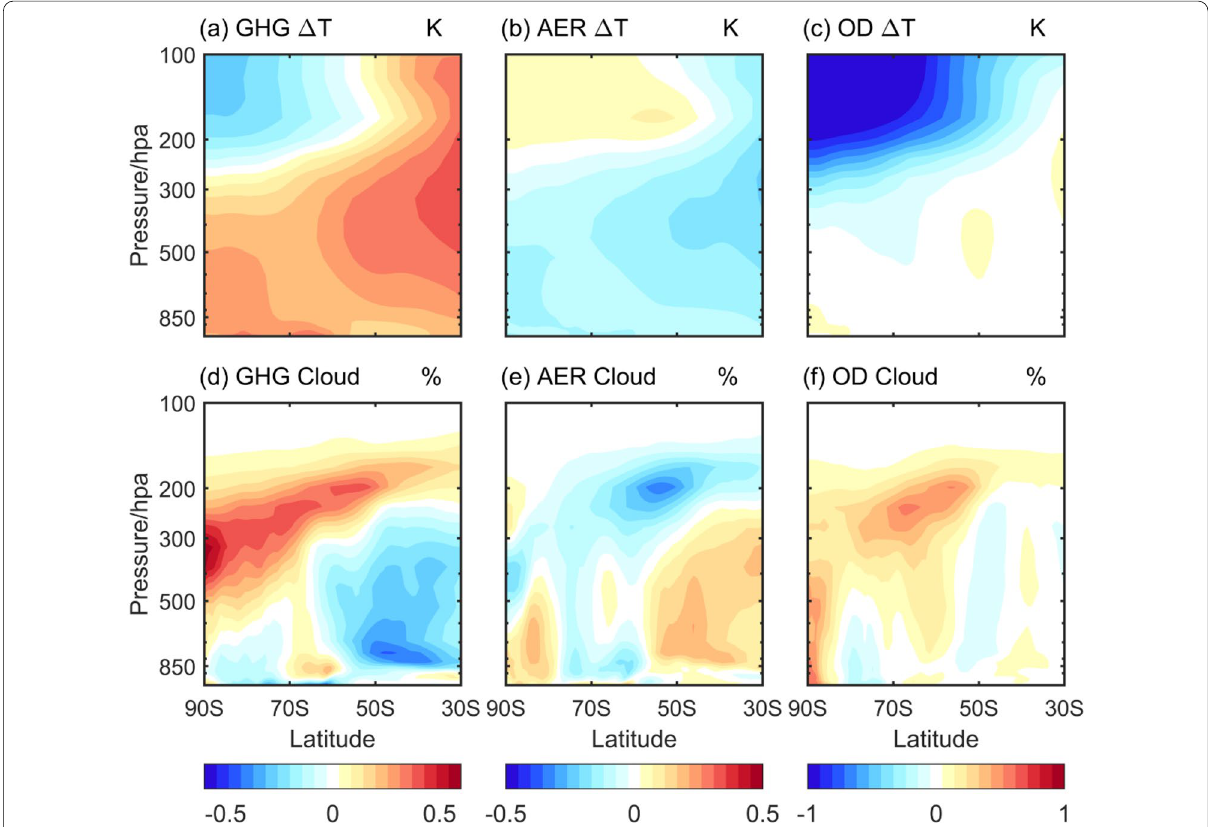
Fig. 5 Changes of zonal mean temperature ( K ) and cloud fraction (%) due to a , d GHG; b , e AER; and c , f OD forcings in the Southern Hemisphere